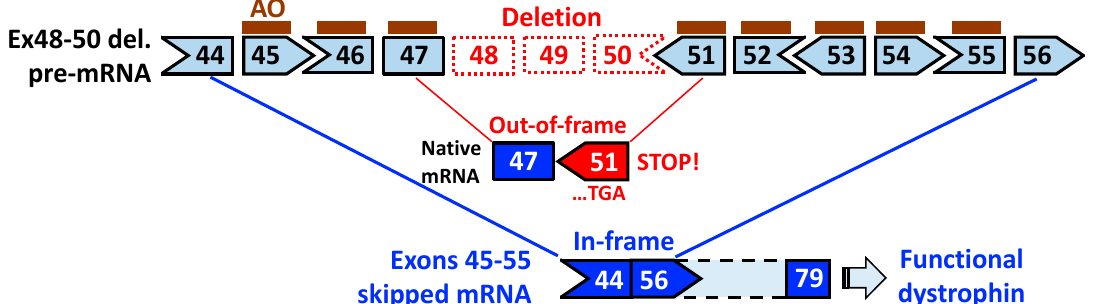
Figure 4. Schematic of exons 45–55 skipping using cocktail antisense oligonucleotides (AOs) for DMD exons 48–50 deletion. Individual AOs are designed to skip each exon within the region from exon 45 to 55. Native out-of-frame mRNAs cannot be translated into dystrophin due to a newly generated premature stop codon in exon 51. Skipping the entire exons 45–55 region by treatment of an AO cocktail leads to the production of truncated but functional dystrophin.